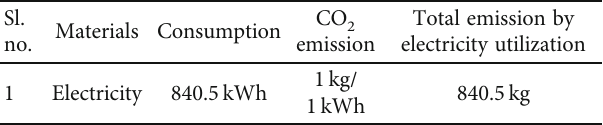
Table 6: Calculation of emission by electricity consumption.